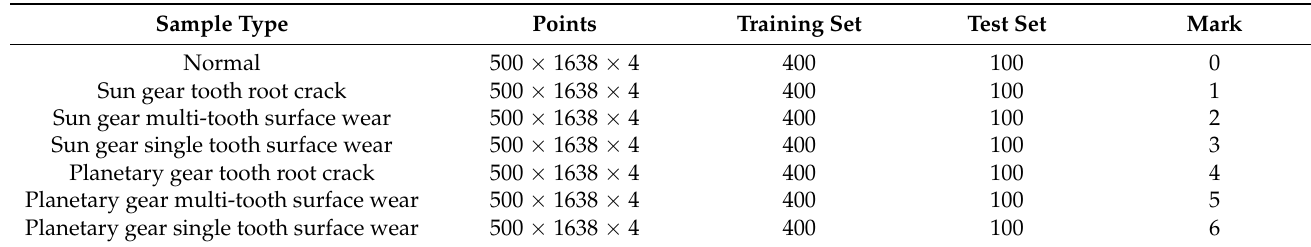
Table 2. Data set